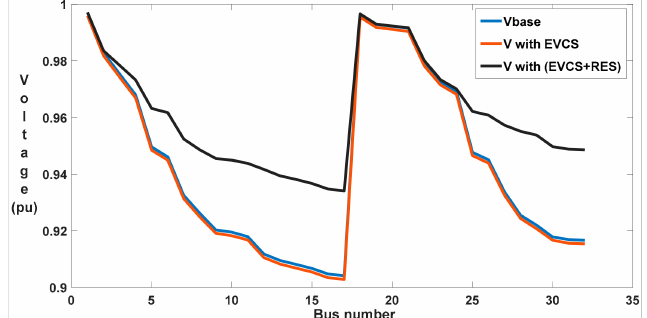
Figure 7. Voltage profile of modified IEEE 33-bus system.